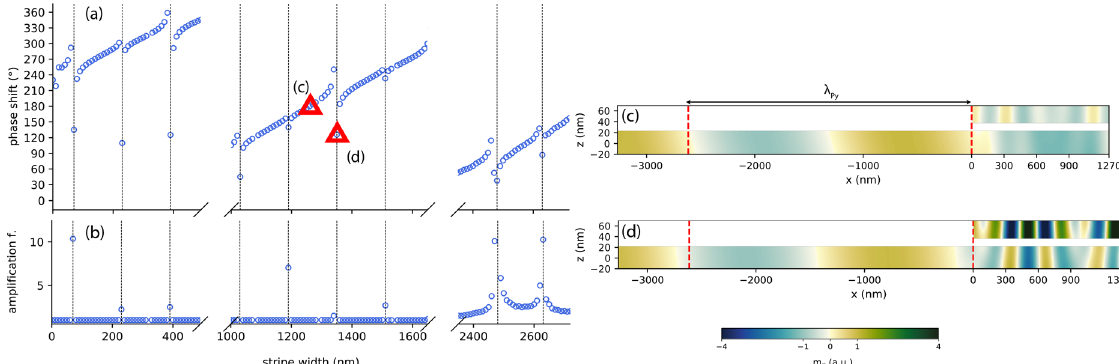
Figure 6. ( a ) Phase shift of SWs at frequency 11 GHz as a function of the stripe width obtained with micromagnetic simulations. ( b ) SW amplification factor in Py below the stripe, defined as in Fig. 5b. ( c ) Snapshot of the dynamic magnetization m x in a system without a resonance at 11 GHz (stripe width: 1270 nm). ( d ) The same in a system possessing a resonance at 11 GHz (stripe width: 1350 nm). The distance between the red dashed lines in ( c , d ) corresponds to the SW wavelength in a uniform Py film at the same